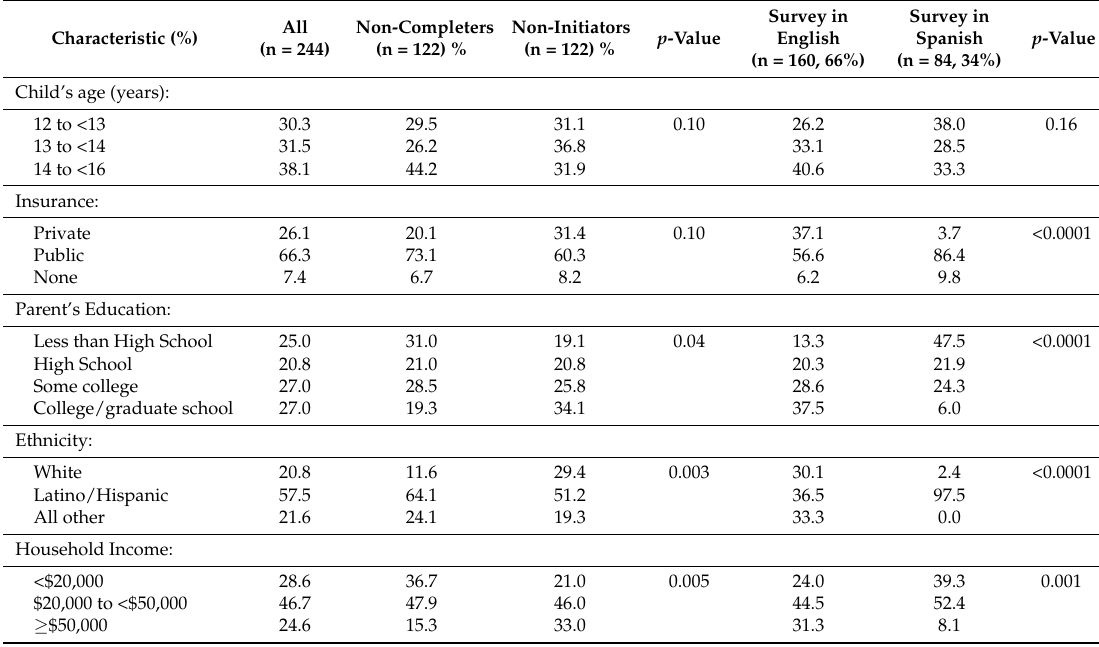
Table 1. Demographics of HPV survey population